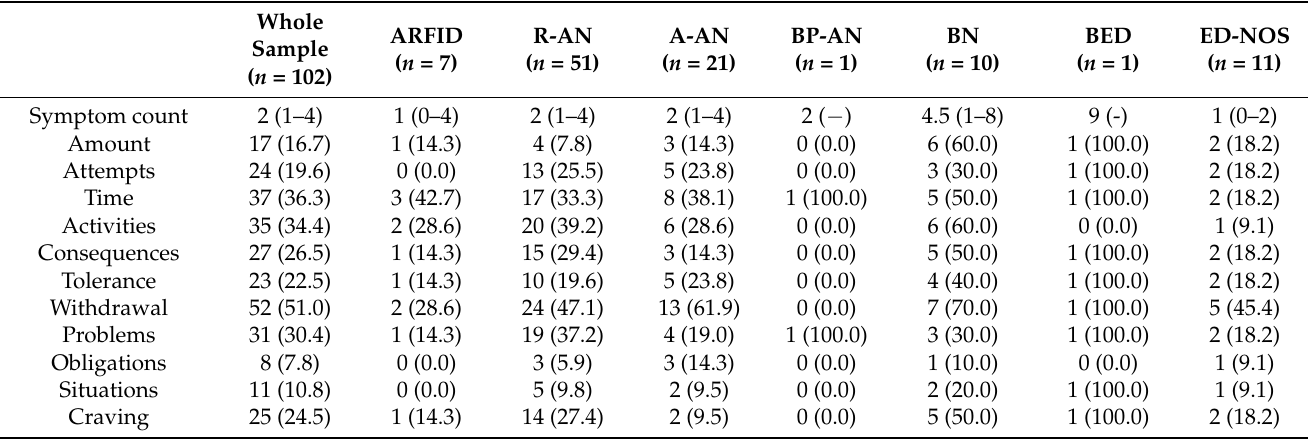
Table 2. Food addiction symptoms profile in the ED